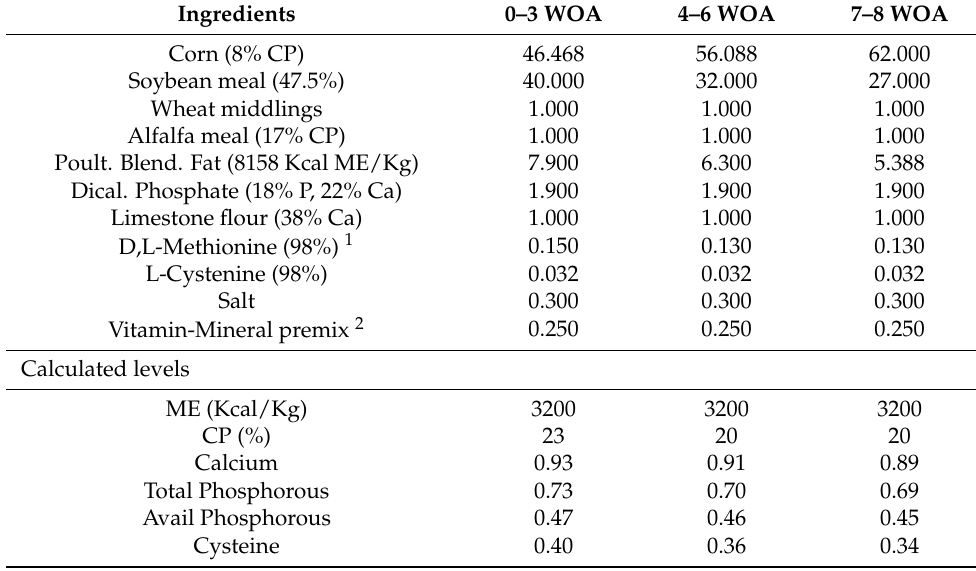
Table 1. Composition of experimental diets fed to Chickens from hatch-8 WOA (%